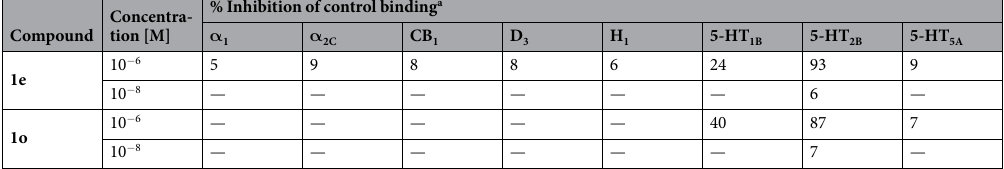
Table 2. Anti-target profiles of selected compounds 1e and 1o . a Experiments performed at Eurofins Cerep.